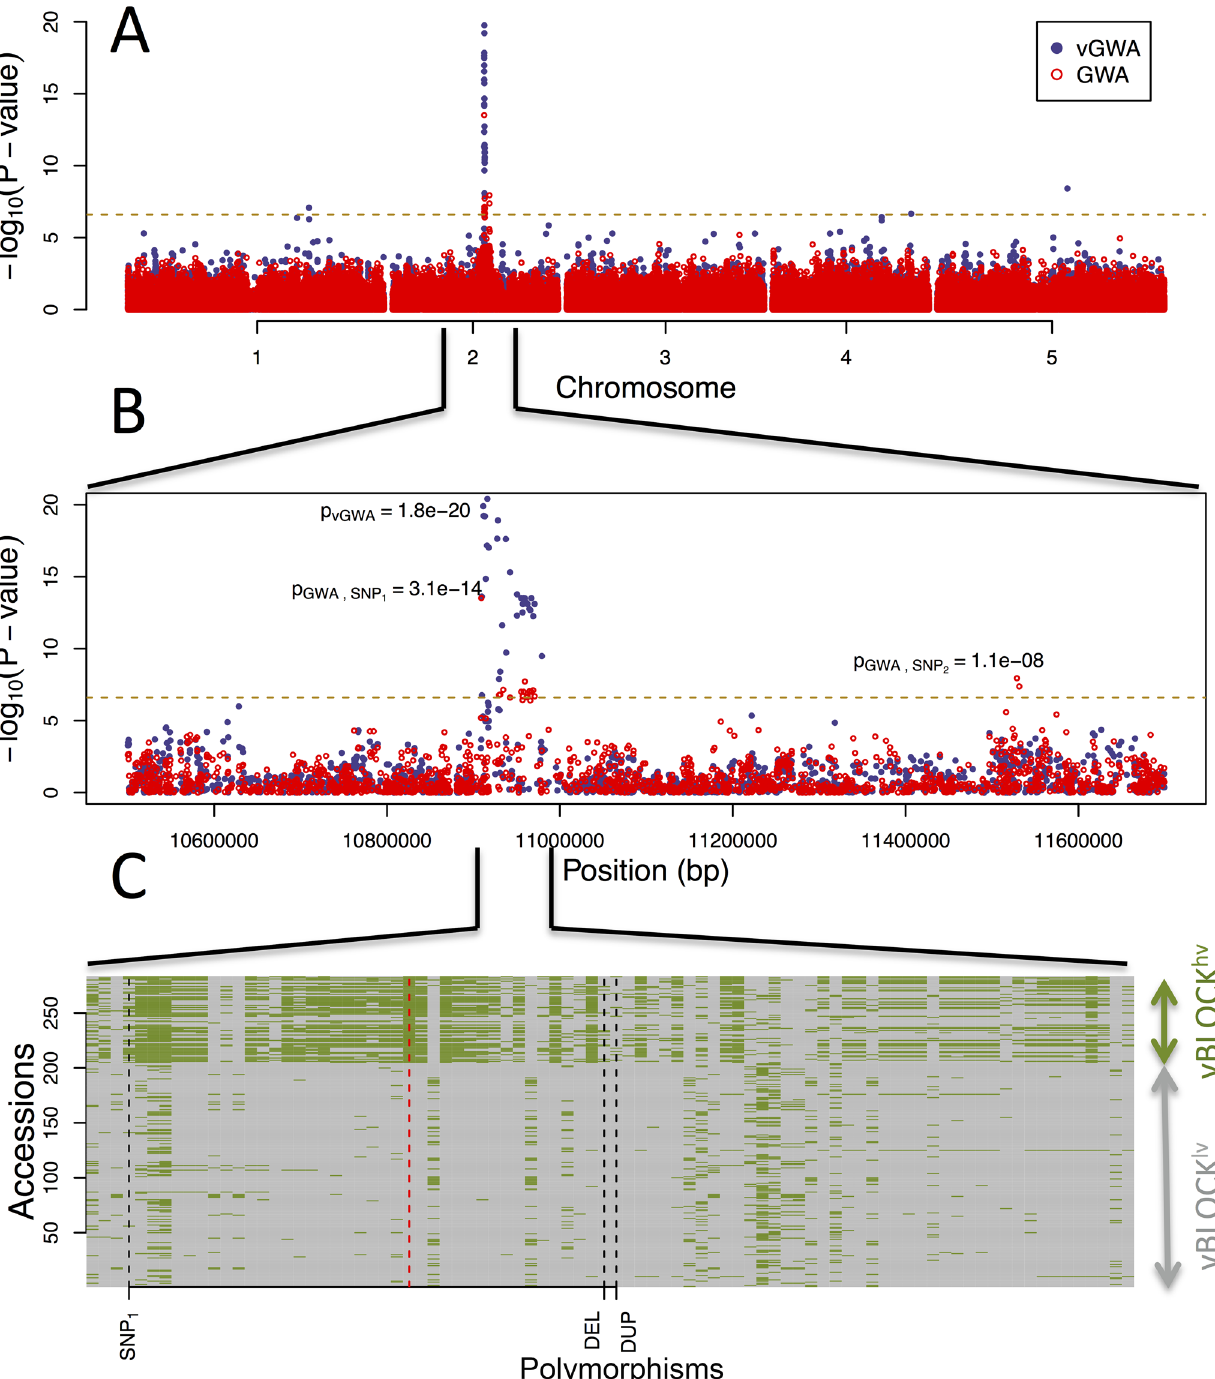
Fig 1. GWA and vGWA analyses for mean leaf molybdenum concentration. (A) Genome-wide results from single-locus vGWA (blue) and GWA (red) analyses across the A . thaliana genome. (B) Region on chromosome 2 where a highly significant genetic variance-heterogeneity was detected for the leaf molybdenum concentrations. Several significant SNPs are detected and these define an extended vGWA associated region (vBLOCK), where the minor alleles at these significant loci define an LD-block associated with a higher phenotypic variance ( vBLOCK hv ). (C) Illustration of the high LD across vBLOCK. The accessions that are homozygous for the minor/major allele are colored green/grey and then sorted according to the genotype of the SNP with the strongest genetic variance-heterogeneity (red dashed line, Table